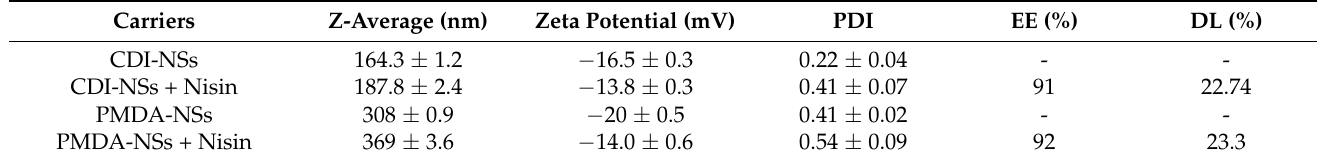
Table 1. Particle size and Zeta potential of drug and drug-loaded nanosponges (error reported as